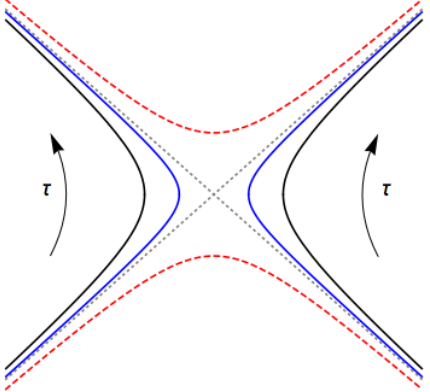
Figure 1 . A graphical representation of the Kruskal extended BTZ black hole (4.2). Here u and v are the standard light-cone coordinates in the plane and (cid:18) is suppressed. The solid black lines are the asymptotic AdS boundaries, the dashed grey lines are the horizons, and the dotted red lines are the past and future singularities. The blue lines indicate curves of constant z